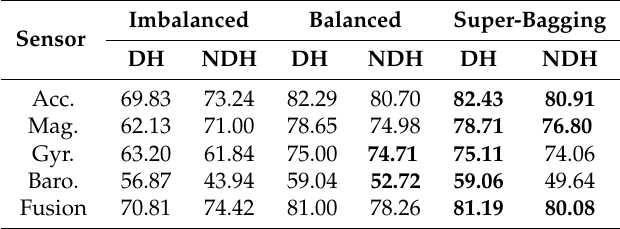
Table 8. Results summary: The bold figures indicate the best averaged UAR (%) of each sensor for Dominant Hand (DH) and Non-dominant Hand